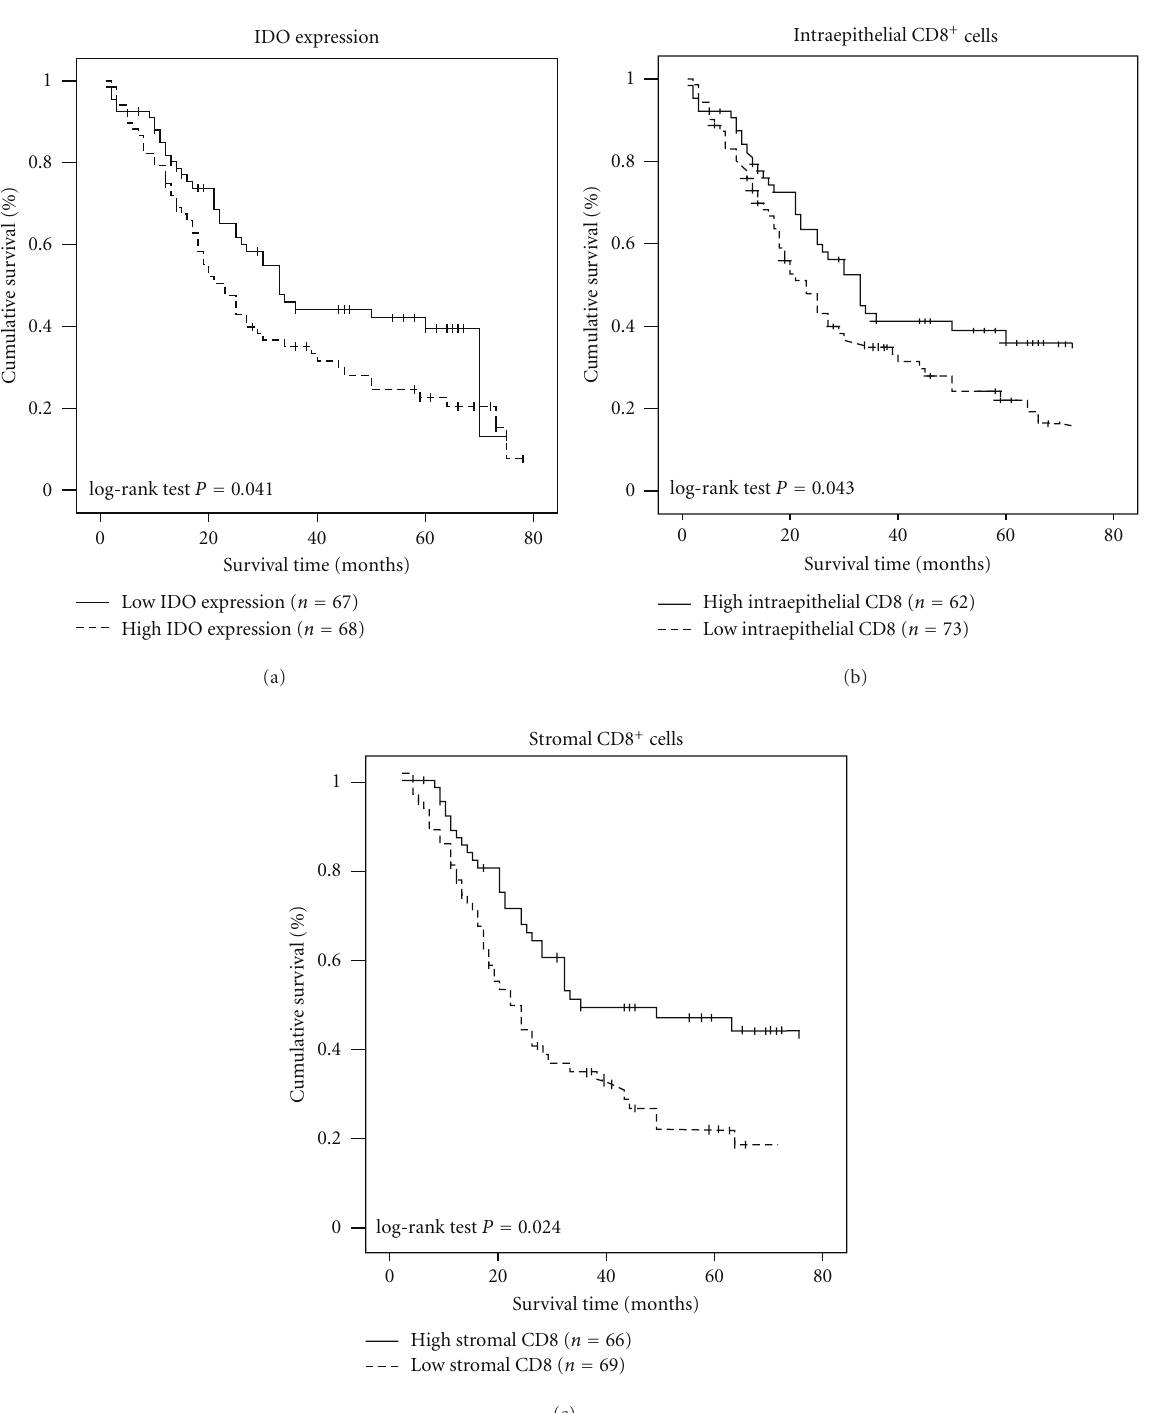
Figure 3: Overall survival curves drawn using Kaplan-Meier method according to the IDO expression, the number of intraepithelial CD8 + TILs and the number of stromal CD8 + TILs in 135 ESCC patients. (a) There was a significant di ff erence in the overall survival between patients with low IDO expression (bold lines) and high IDO expression (dotted lines). (b) Significant di ff erences in overall survival between the high intraepithelial CD8 + TIL groups ( ≥ 10) and the low intraepithelial CD8 + TIL groups ( < 10). (c) Significant di ff erences in overall survival between the high stromal CD8 + TIL groups ( ≥ 20) and the low stromal CD8 + TIL groups ( <